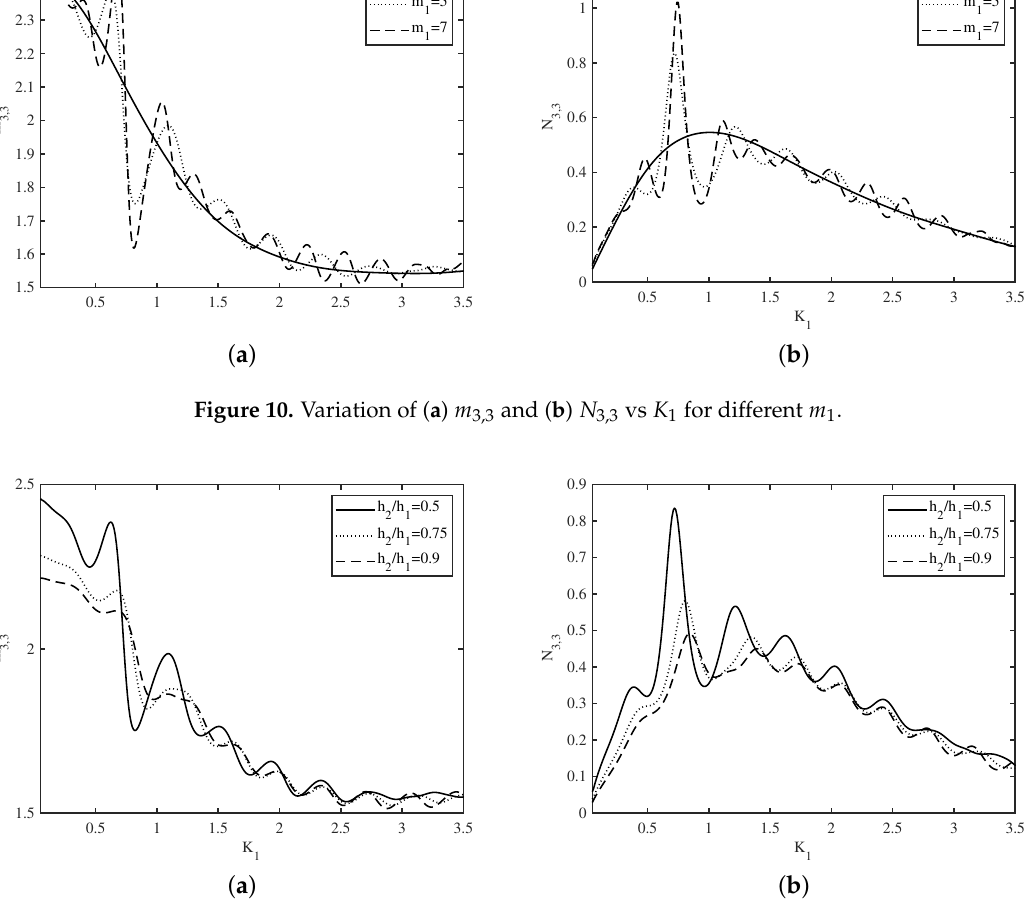
Figure 11. Variation of ( a ) m 3,3 and ( b ) N 3,3 vs K 1 for different h 2 / h 1